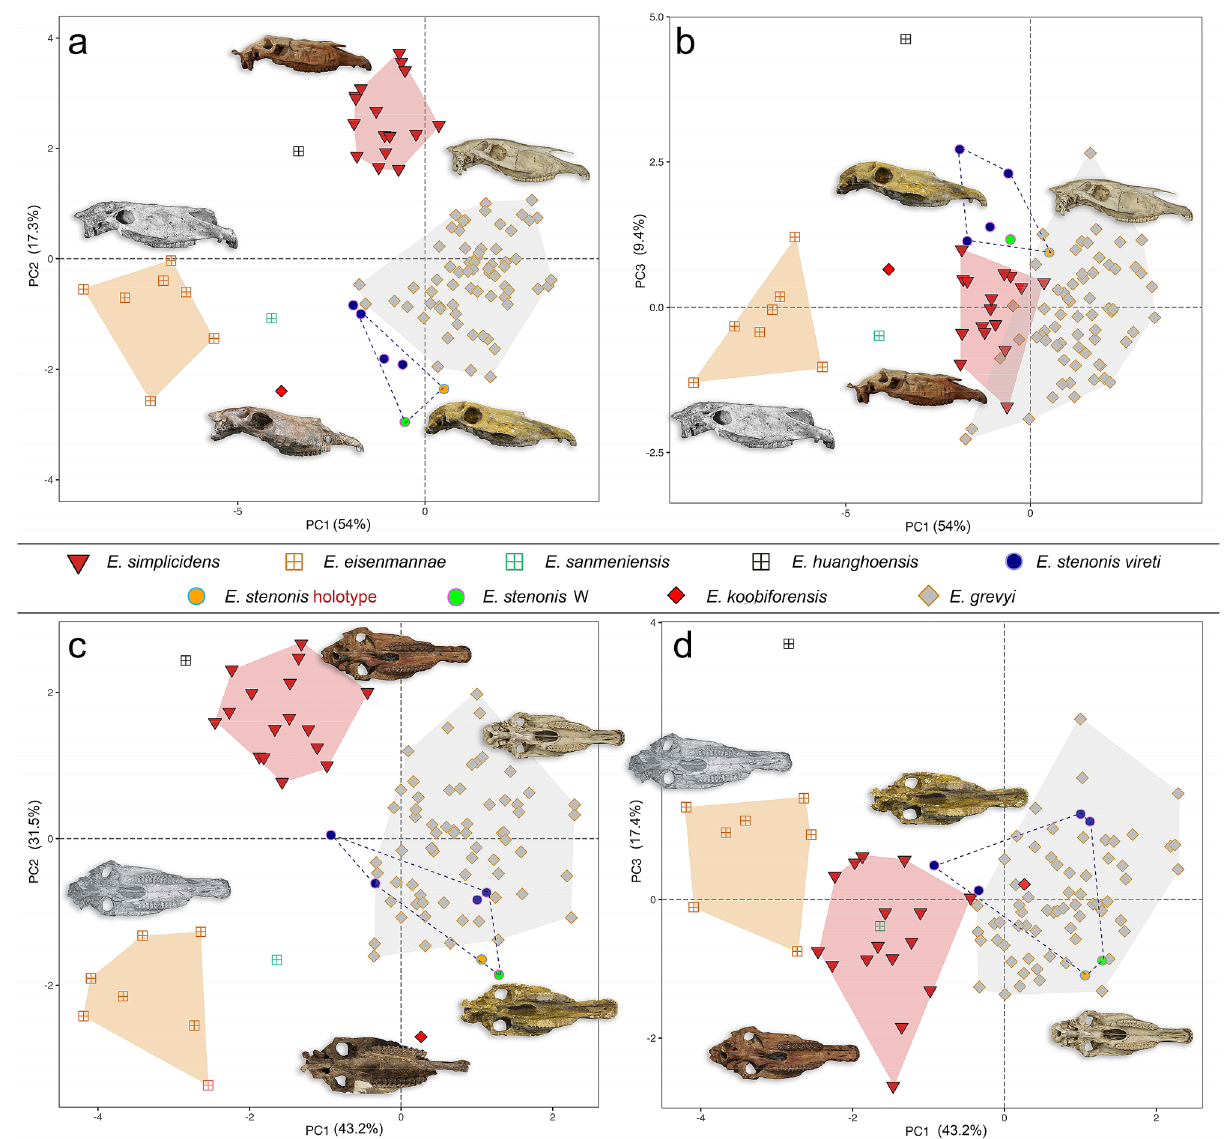
Figure 3. Results on PCA based on the selected skull measurements. Plots primarily obtained by R Studio Software v.1.4.103 2020 50 packages ggplot2() v.3.3.3 51 and prcomp() v.3.6.2 52 . ( a , b ) show the PC1 versus PC2-PC3 outcomes on the skull basal and lateral measurements, whereas ( c , d ) show the PC1 versus PC2-PC3 results for the skull basal measurements. The analyses have been developed by the Software R using the packages prcomp() and ggplot2(). The original database is given in Table S3, whereas the loadings plots are shown in Figure